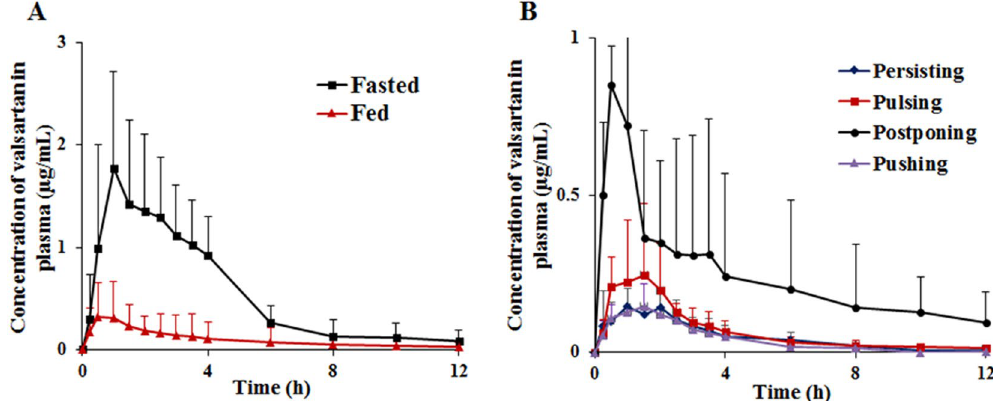
Figure 4. Plasma concentration-time profiles of valsartan capsules varied by food taking in beagles. Fasted and fed states (n = 12). ( A ) “4P Modes” after a single oral dose of 80 mg valsartan per beagle ( B ).